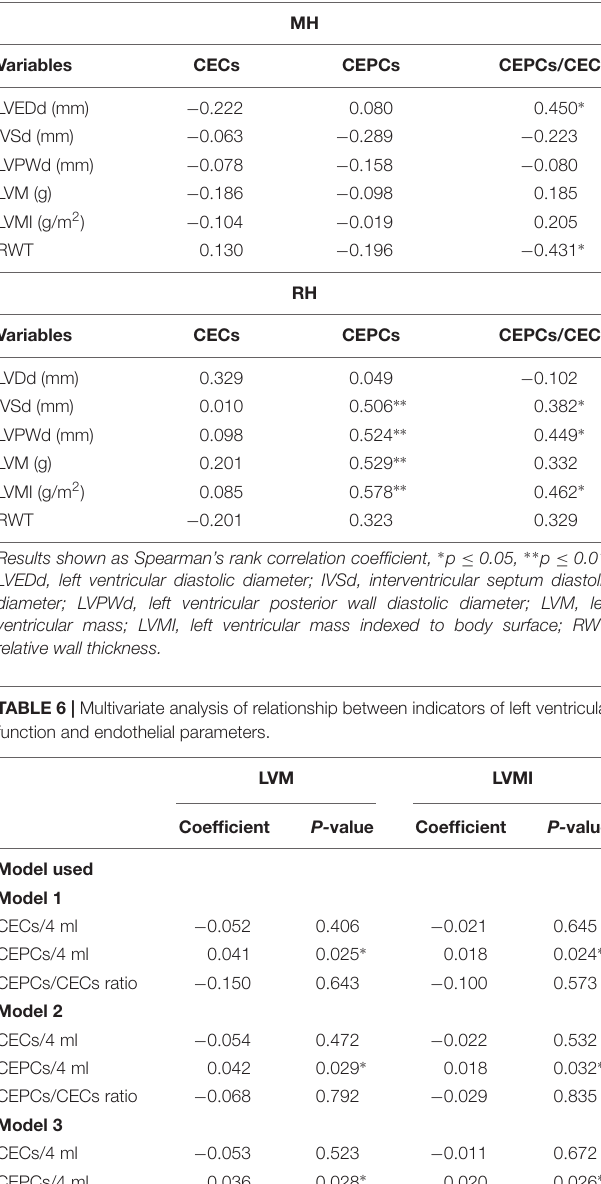
TABLE 5 | Univariate analysis of relationship between left ventricular hypertrophy parameters and markers of endothelial injury in MH and RH group.